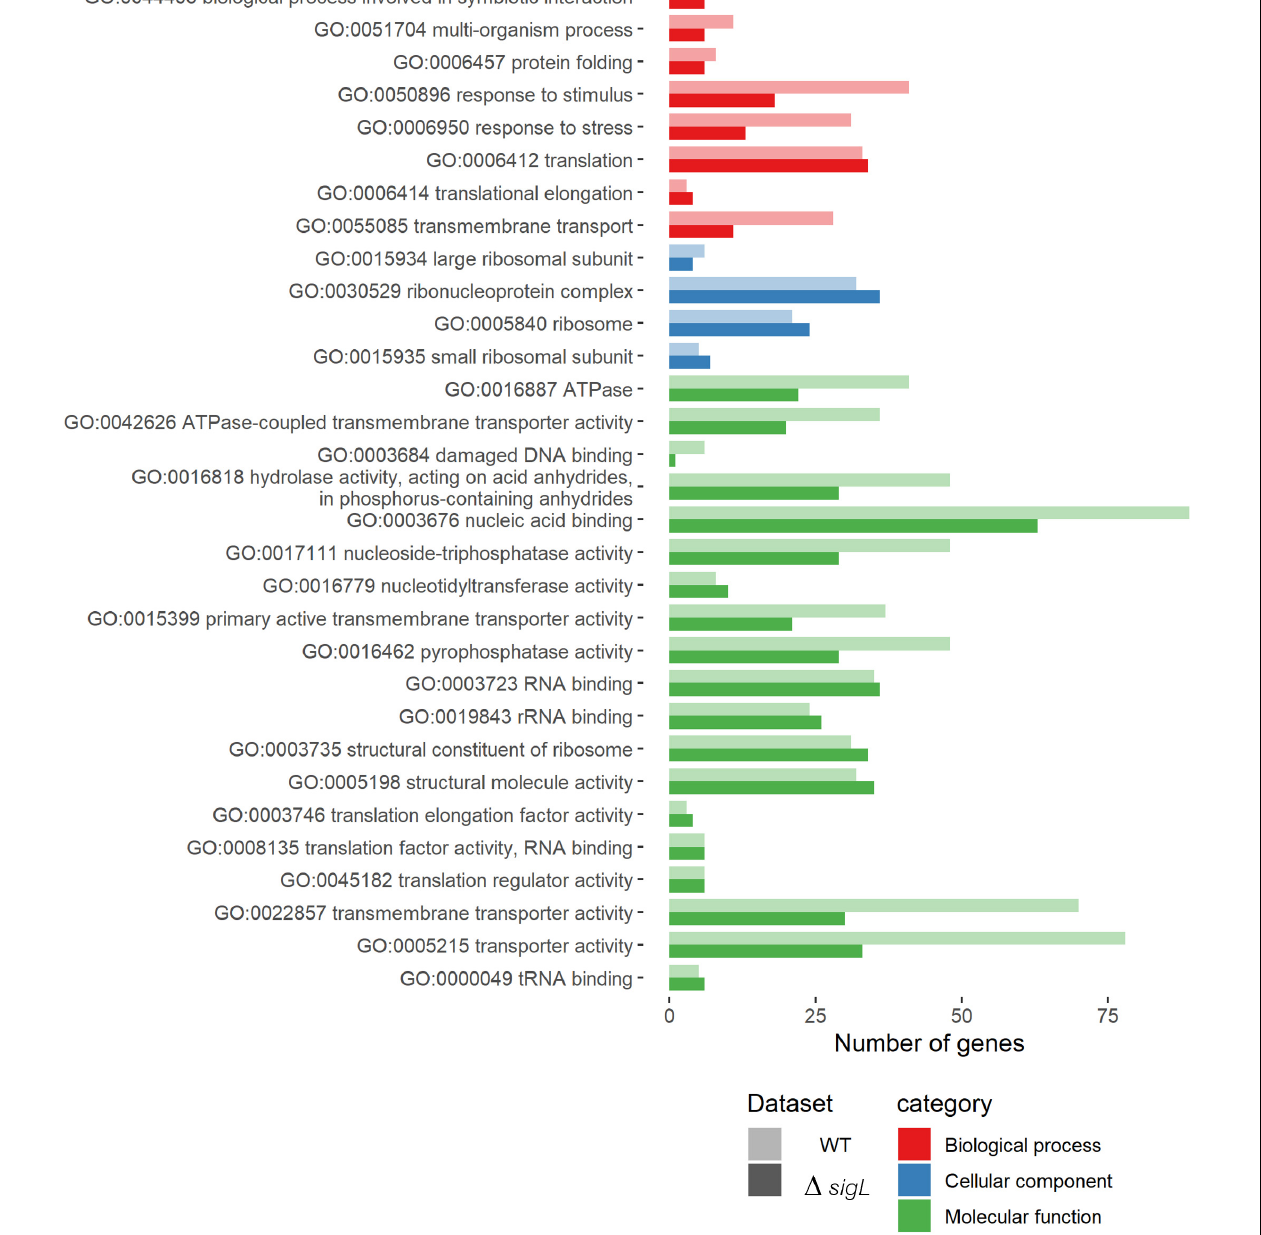
FIGURE 4 | Enriched gene ontology (GO) terms in upregulated genes during intracellular growth of Listeria monocytogenes strain 10403S WT (light shade) and (cid:49) sigL strain (dark shade). The x -axis represents the number of upregulated genes containing that GO term. Detailed information is shown in Supplementary Tables 4, 6